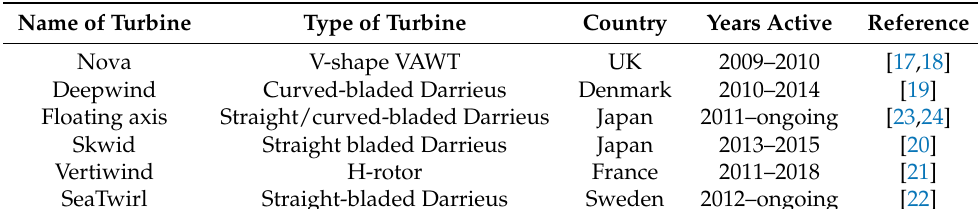
Table 1. Summary of floating VAWT research activity over recent years.